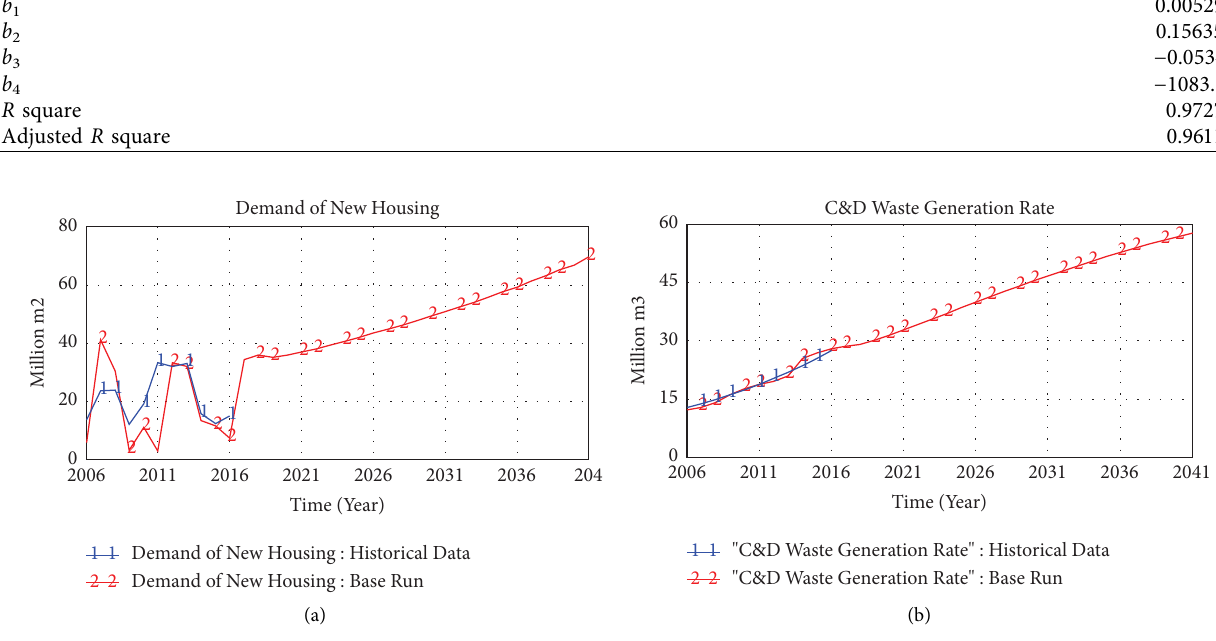
Figure 4: (a) Comparison of housing demand and historical data and (b) comparison of C&D waste generation rate with historical